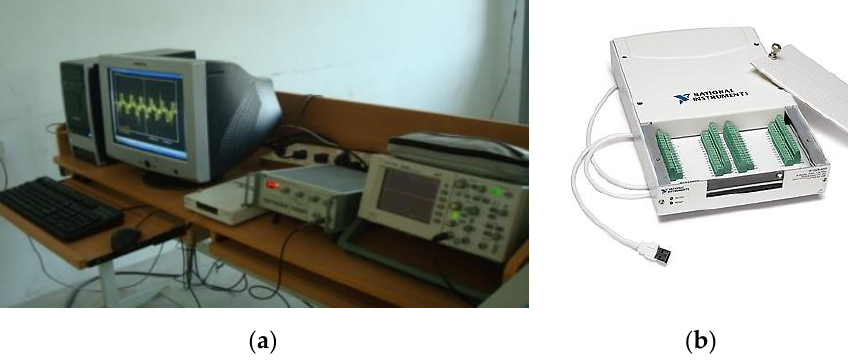
Figure 14. ( a ) Data acquisition system interfaced with LabVIEW software in PC ( b ) NI USB-6251